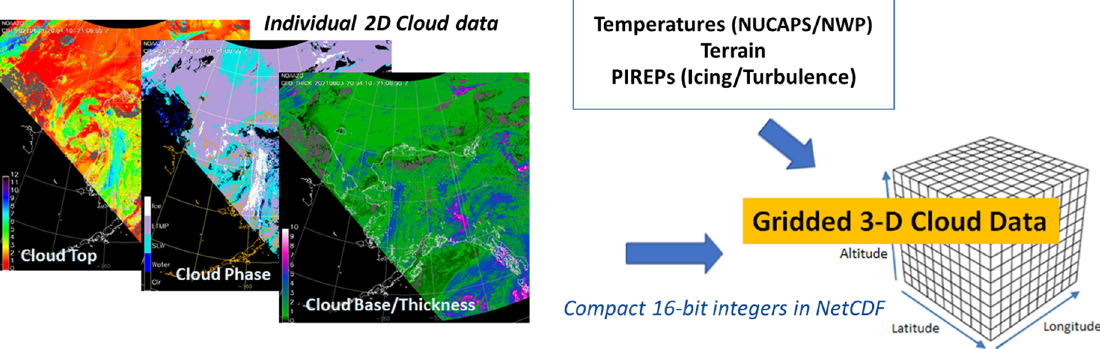
Figure 13. Schematics of the new 3-D gridded cloud data field generated from multiple cloud products, temperatures, and terrain data together with PIREPs (icing and turbulence).